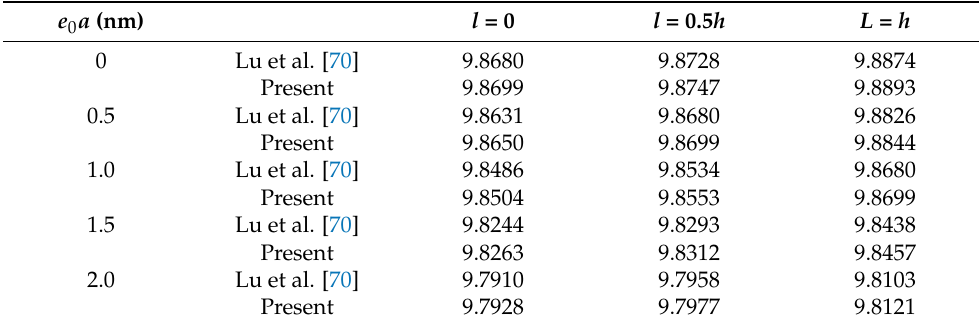
Table 1. Comparison of the natural frequencies ( ( ω n L 2 / h t ) consideration of nonlocal strain gradient ( L = 50 nm, h t = 1